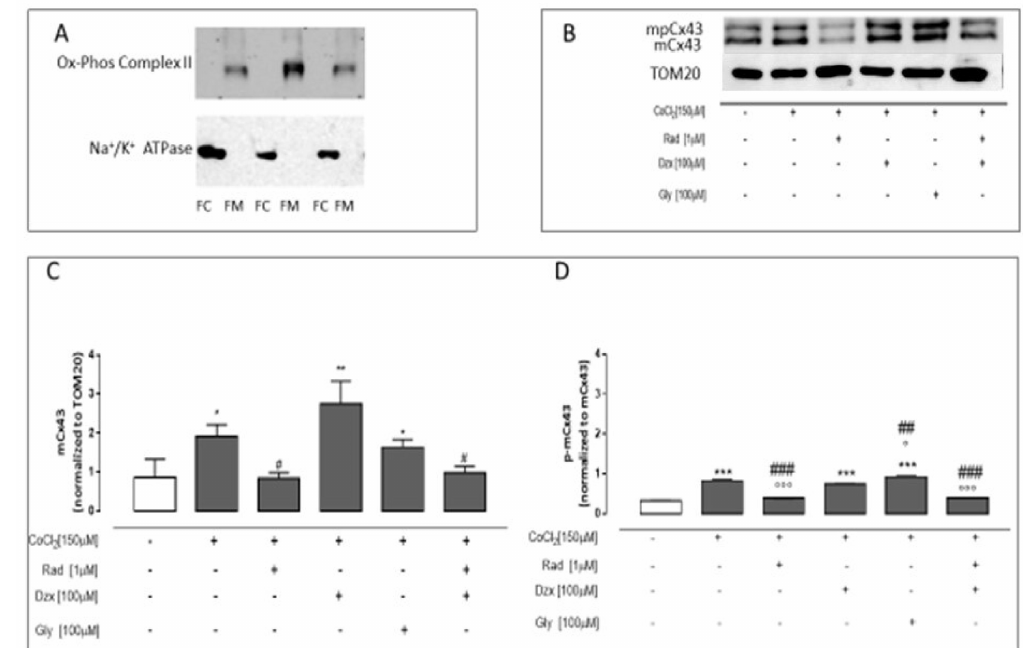
Figure 1. Effects of the opening of K ATP channels on mitochondrial Cx43 expression in CoCl 2 -induced hypoxia. H9c2 cells were treated for 3 h with CoCl 2 (150 µ M); rad (1 µ M), dzx (100 µ M) and gly (100 µ M) were added 30 min before CoCl 2 administration. Panel ( A ) shows representative Western blots of Na + /K + -ATPase and of OXPHOS Complex II used as markers to demonstrate the purity of the cytosolic and mitochondrial extracts, respectively. Mitochondrial Cx43 expression was detected by Western blotting. Tom20 protein expression was used as loading control ( B ). Panel ( C ) shows the histograms of mCx43 normalized to Tom20. Panel ( D ) shows the histograms of mpCx43 normalized to mCx43. Results are expressed as mean ± S.E.M. from at least three independent experiments, each performed in duplicate. Data were analysed by one way ANOVA and multiple comparisons were made by Bonferroni post-test. * p < 0.05, ** p < 0.005 and *** p < 0.001 vs. untreated cells; ◦ p < 0.05 and ◦◦◦ p < 0.001 vs. CoCl 2 -treated cell; # p < 0.05, ## p < 0.005 and ### p < 0.001 vs. CoCl 2 and dzx co-treated